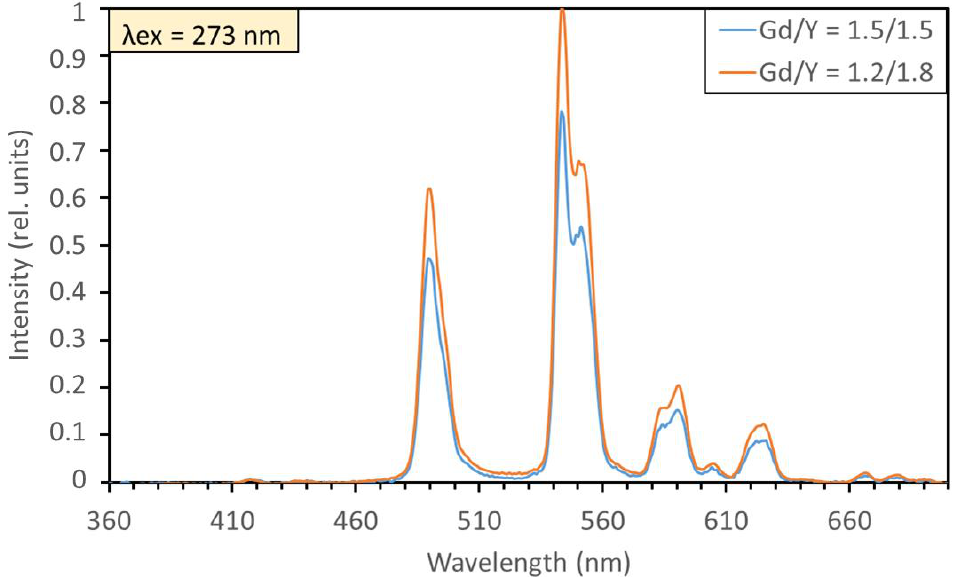
Figure 4. Room temperature PL spectra at excitation in Tb 3+ interconfiguration transition (λex = 273 nm) of GYAGG:Tb-2 and GYAGG:Tb-3 samples. Inset includes the Gd/Y ratio, assuming a homogeneous distribution of the Tb ions between positions occupied by Gd and Y ions. Therefore, the Gd and Y indexes are each increased by 0.1.